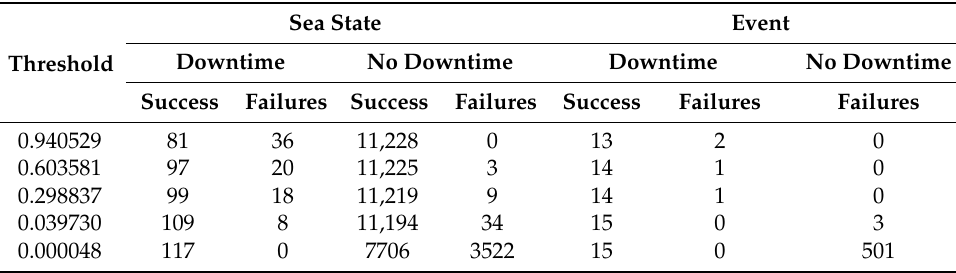
Table 4. Confusion matrix data with different thresholds for sea states (1 h) and events (at least 2 consecutive hours).